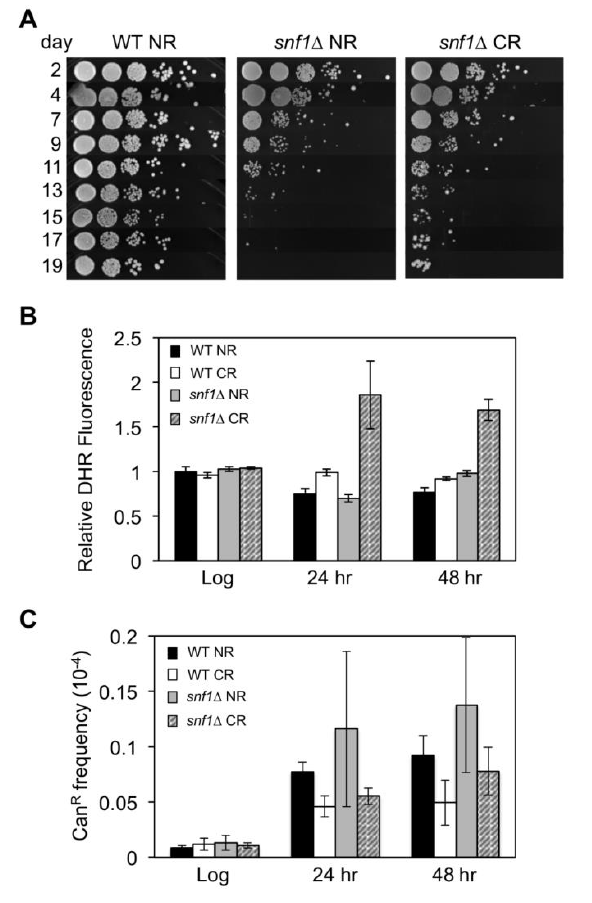
FIGURE 1: Frequent adaptive regrowth of snf1 ∆ strains during chronological aging under caloric restriction (CR- 0.5% glucose) conditions. (A) Qualitative CLS assay showing the rapid loss of viability by a snf1 ∆ strain (JS1394) compared to WT (JS1256) as the cells chronologically age in expired SC NR (2% glucose) medi- um. (B) Reactive oxygen species (ROS) accumulation in snf1 ∆ strains grown into stationary phase during CR culture conditions, as indicated by dihydrorhodamine 123 (DHR) staining. (C) CAN1 gene mutation frequency in WT and snf1 ∆ strains grown under